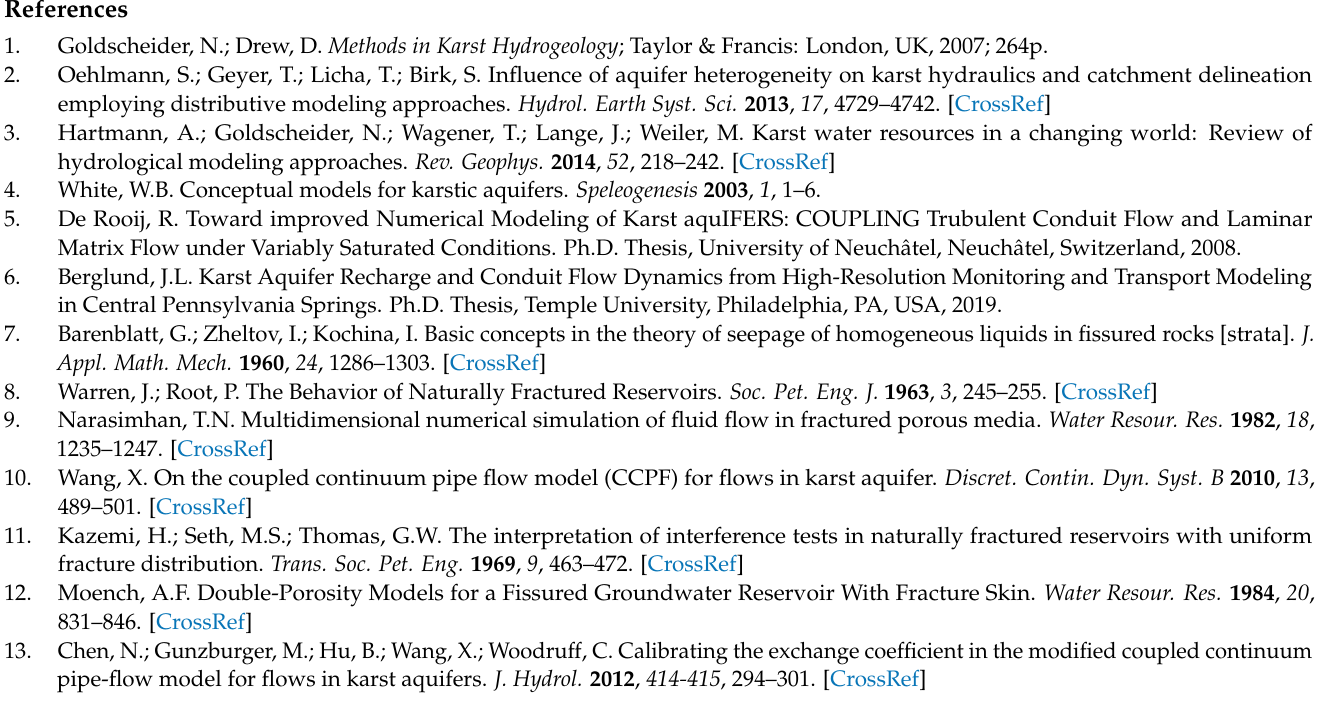
flow. Table S2. The characteristics of the spring hydrograph in the scenario A1. Table S3. The characteristics of the spring hydrograph in scenario B1. Table S4. The characteristics of spring hydrograph in response to changes of conduit diameter in scenario A2. Table S5. The characteristics of spring hydrograph in response to changes in conduit diameter in scenario B2. Table S6. The spring hydrograph changes influenced by matrix hydraulic conductivity changes in scenario A3. Table